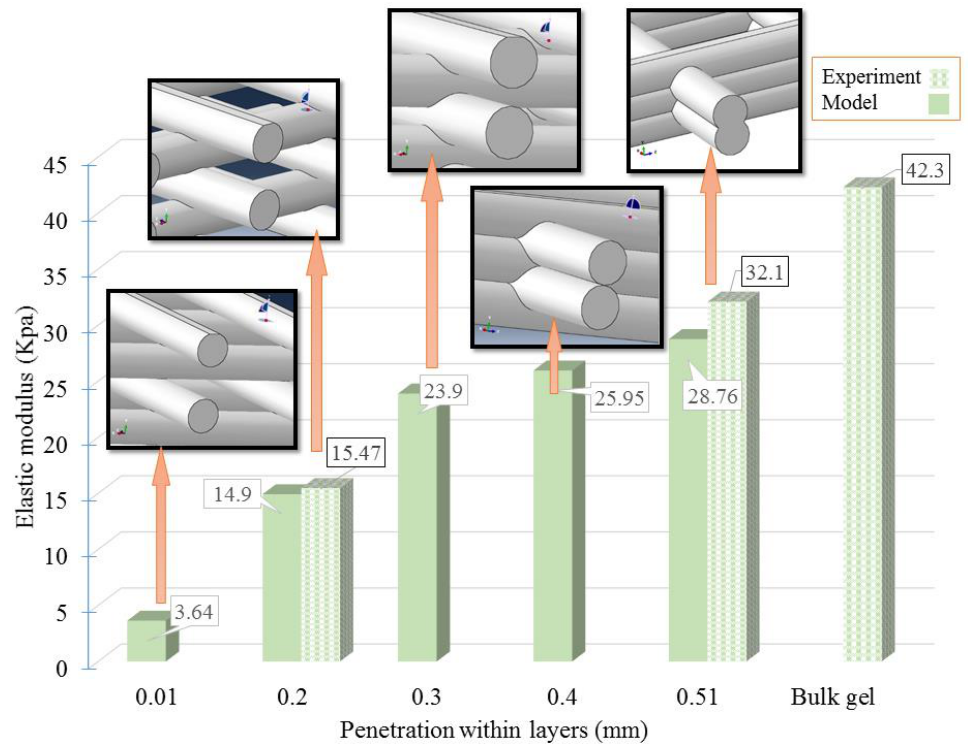
Figure 5. Effect of penetration within layers on the elastic modulus of alginate scaffolds with a strand diameter of 0.58 mm and a distance of 1 mm between two adjacent strands.